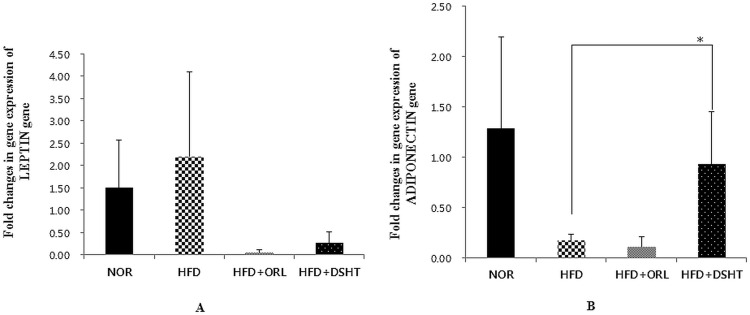
Effect of DSHT on leptin and adiponectin gene expressions in HFD-fed C57BL/6j mice.(A) Folds changes in leptin gene expression in normal (NOR), high fat diet (HFD), orilistat (ORL), and daesiho-tang (DSHT) fed animals after 12 weeks. (B) adiponectin gene expression in NOR, HFD, HFD+ORL and HFD+DSHT treated animals. Data were represented as mean ± SD (n = 4). The results were compared by Student’s t-test (* corresponds to p<0.05). The error bars represent the SD.